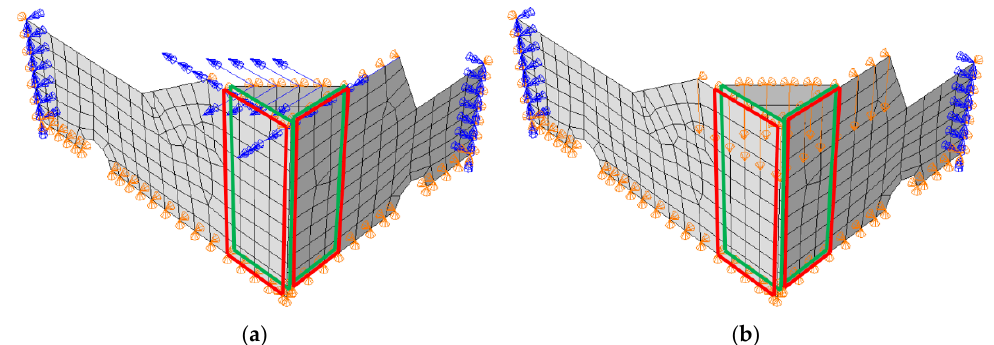
Figure 4. Finite element model of open-top boxes for transport of fruits with boundary conditions and mesh (the red and green rectangles indicate where the vertical faces are in contact): ( a ) buckling step; ( b ) compression step.